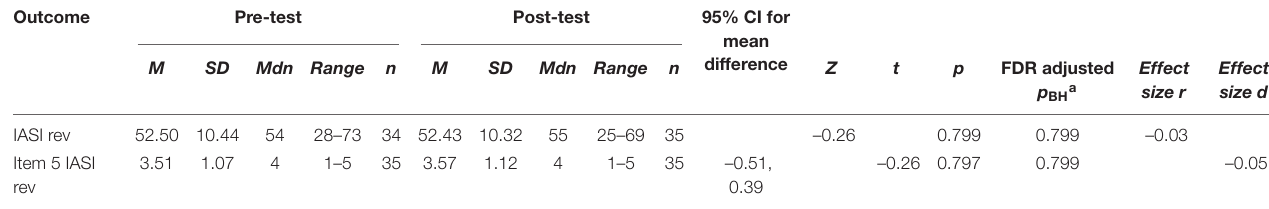
TABLE 4 | Results of Wilcoxon signed-rank test and paired-samples t -test and descriptive statistics for IASI rev total score and Item 5 IASI rev score ( n = 35).